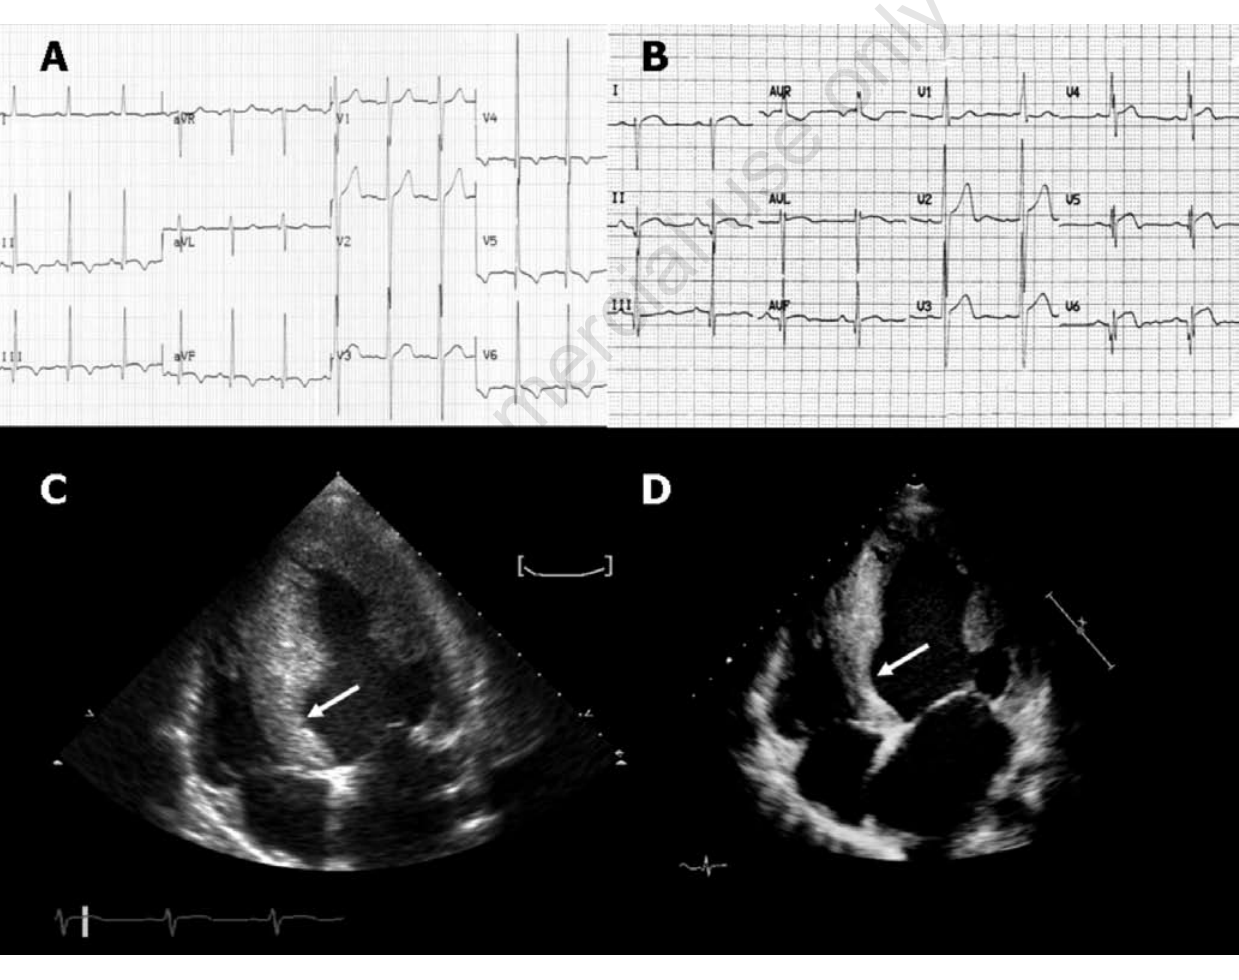
Figure 2. Electrocardiograms (ECG) and echocardiograms of the daughter. A) ECG at the age of 7 years old (halved voltages). Extreme left ventricular (LV) hypertrophy and infero-postero-lateral necrosis with negative T waves in the infero-lateral leads. B) ECG at the age of 23 years old (note that voltages are not halved on this occasion). Compared to the previous one, decreased voltages and QRS enlarge- ment are evident. Infero-lateral pseudonecrosis and antero-lateral ST segment elevation with biphasic T waves are present. C) Echocardiography at the age of 7 years old. The apical 4-chamber view shows marked left ventricular hypertrophy prevalent at postero- lateral level with normal ventricular cavity. As the mother, a relative wall thinning localized to the basal interventricular septum is evi- dent (white arrow). D) Echocardiohrapy at the age of 23 years old. Compared to the previous one, the apical 4-chamber view shows thinned LV walls and LV enlargement. The aspect of thinness of the basal interventricular septum is still evident (white